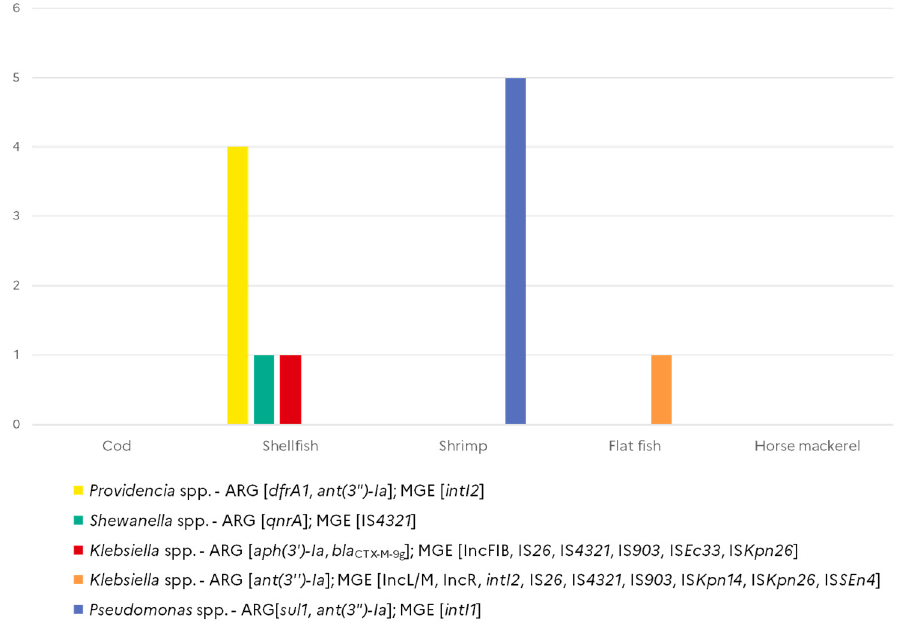
Figure 4. Co-occurrence of antimicrobial resistance genes and mobile genetic element markers in Gram-negative isolates from seafood ( N =